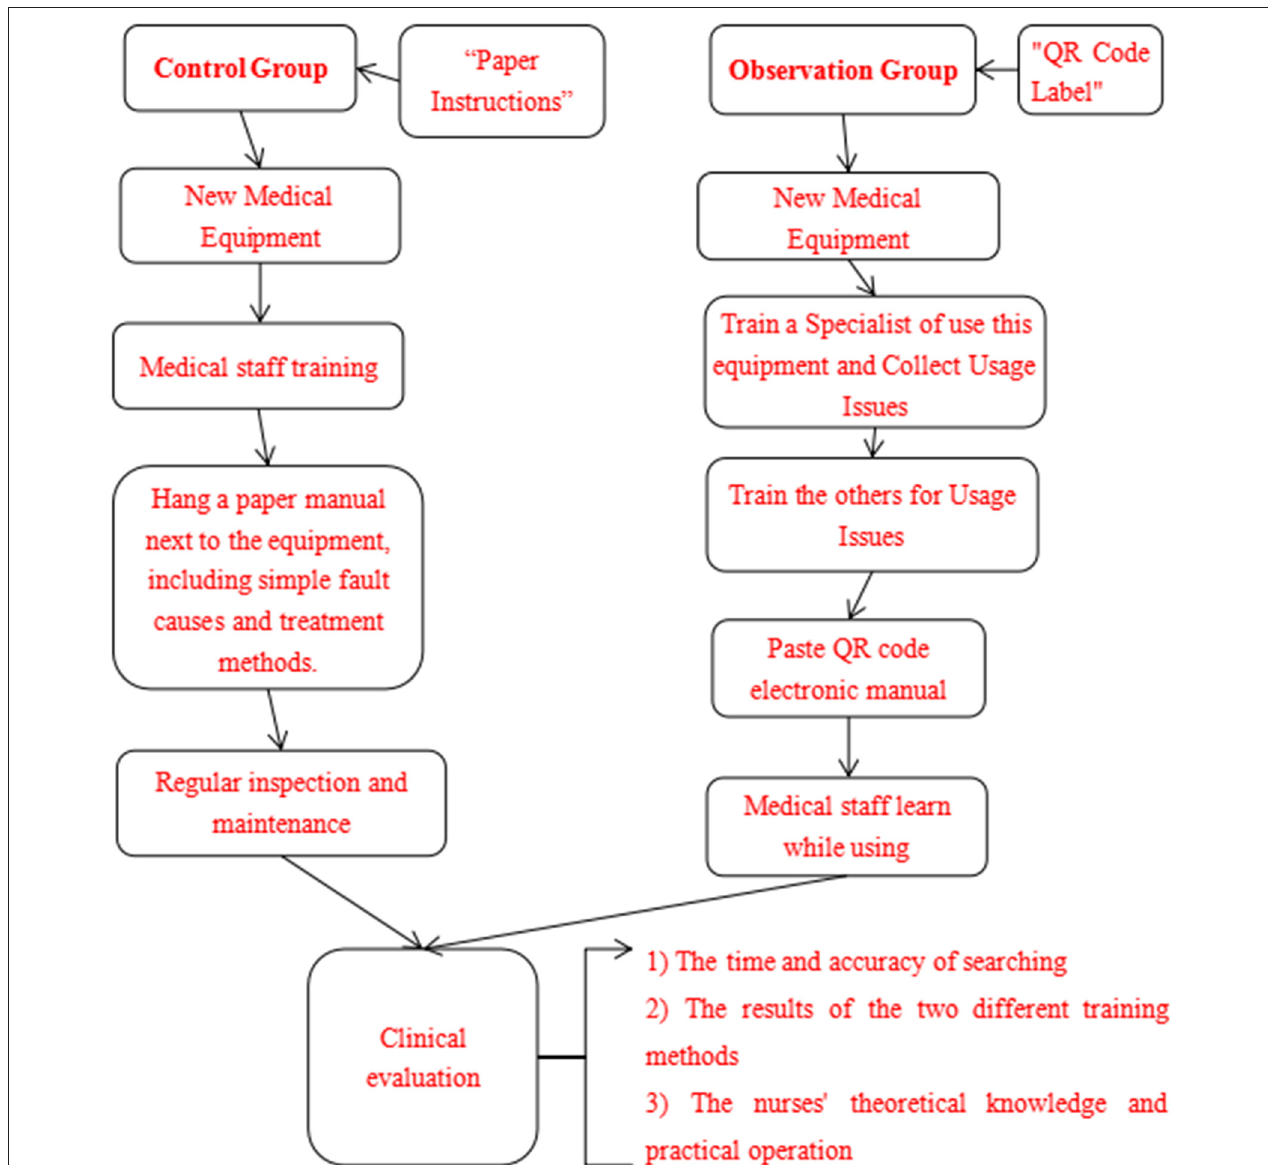
FIGURE 1 | The training flow chart of the control group and the observation